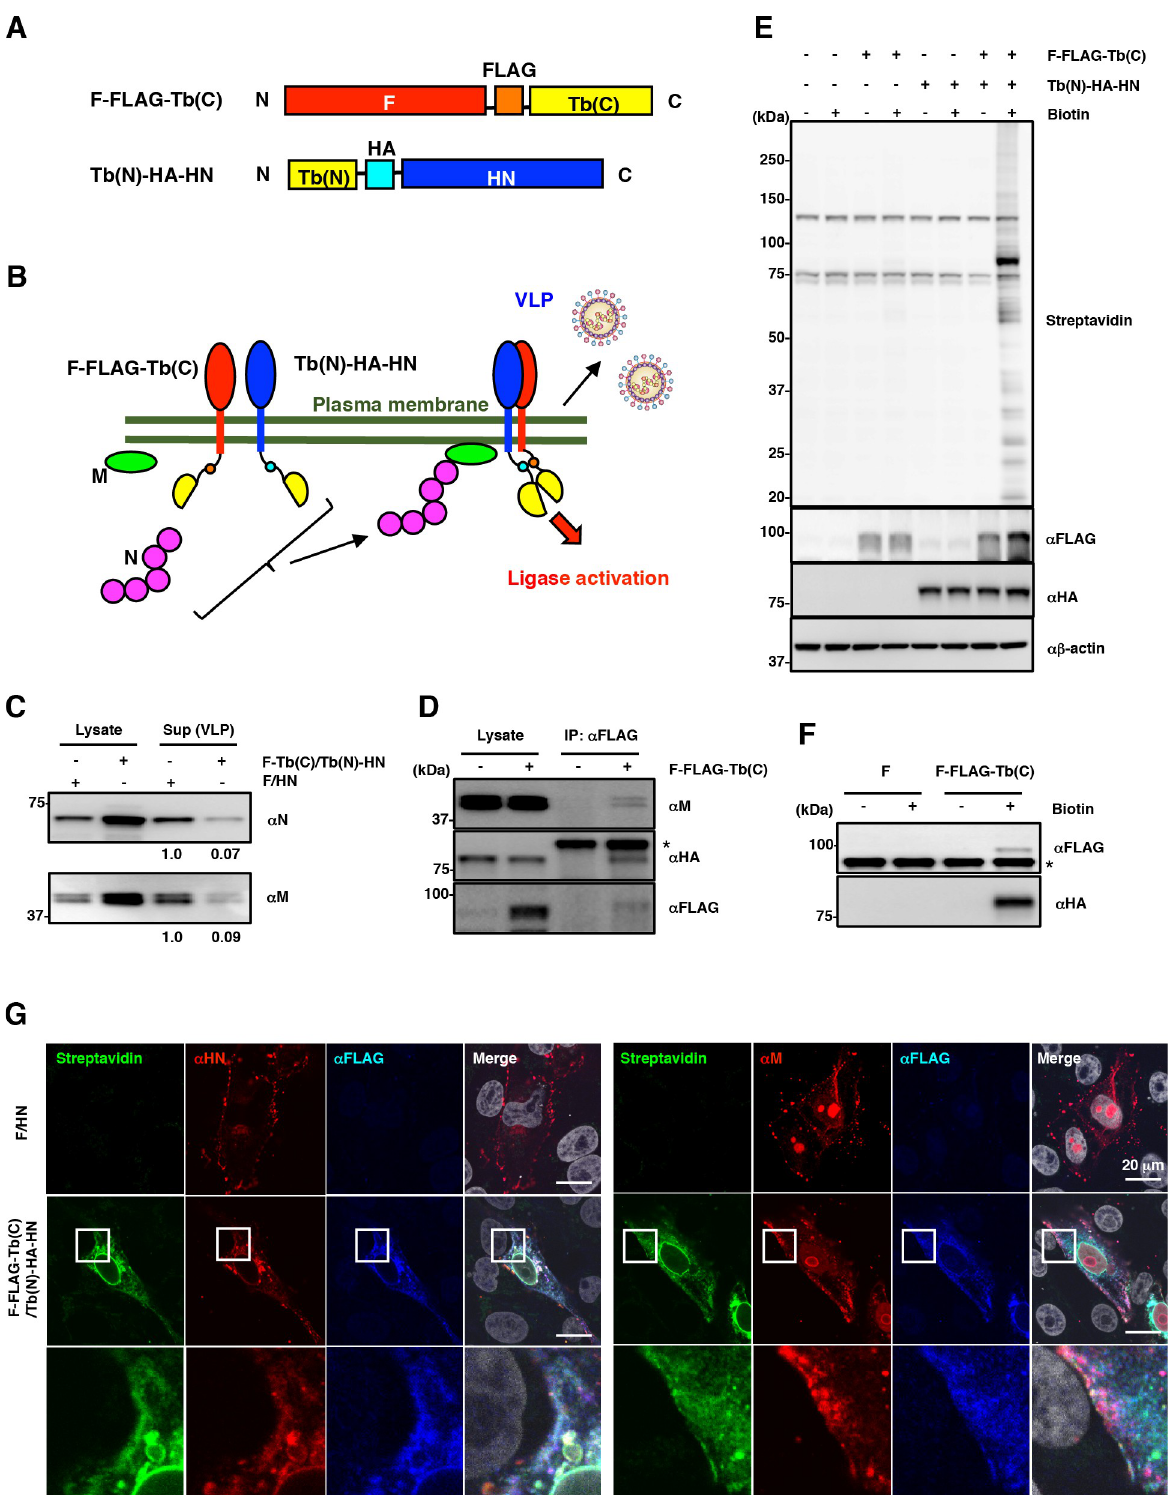
Fig 1. Search for host factors located in the vicinity of the cytoplasmic tails of the MuV F and HN proteins. (A) Schematic diagrams of F-FLAG-Tb(C) and Tb(N)-HA-HN. (B) Schematic overview of the split-TurboID-based proximity biotinylation using a virus-like particle (VLP) assay system. (C) VLP assay showing the amounts of the N and M proteins expressed in the cells (Lysate) and released into the supernatants (Sup).